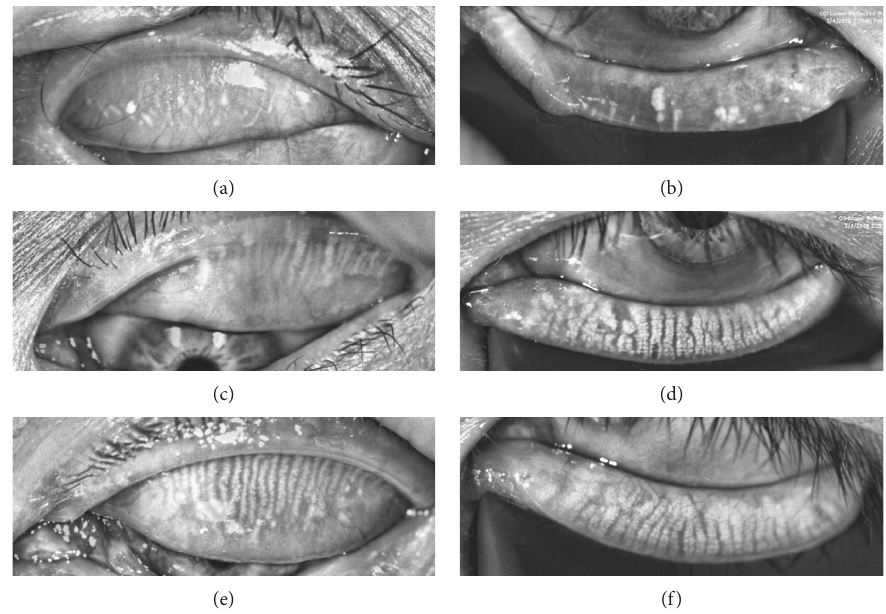
Figure 1: Bilateral meibomian gland loss 12 months after unilateral radiotherapy. Meibography shows the upper and lower meibomian gland loss in the diseased eye (a, b) and contralateral eye (c, d) of a 46-year-old male 12 months after unilateral radiotherapy due to right conjunctival MALToma and relatively normal meibomian gland of the left eye of a 52-year-old male control (e, f). MALToma: mucosa- associated lymphoid tissue